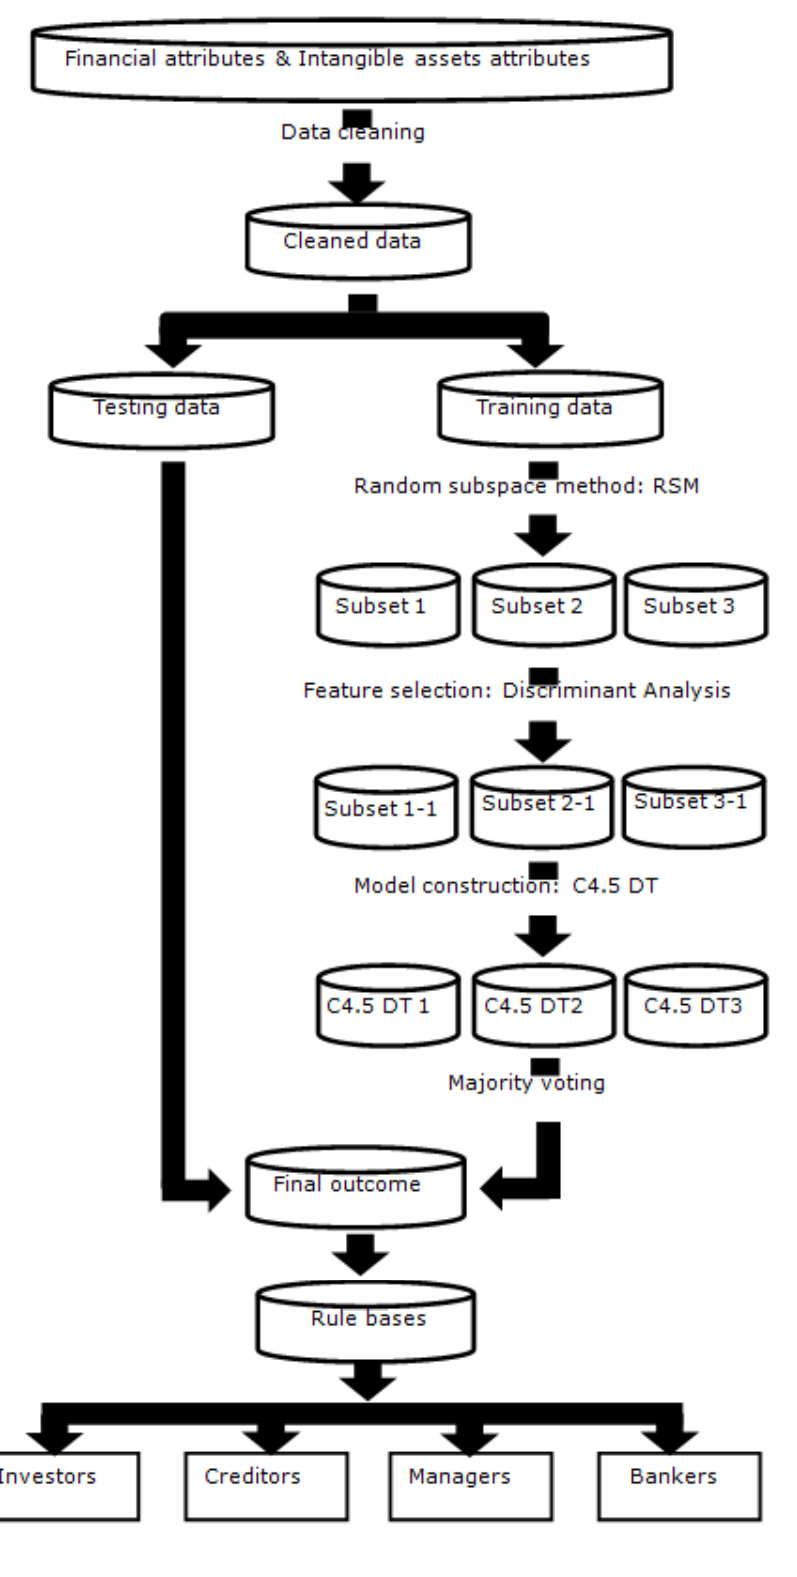
Figure 2. The flowchart of the multi-agent hybrid mechanism: